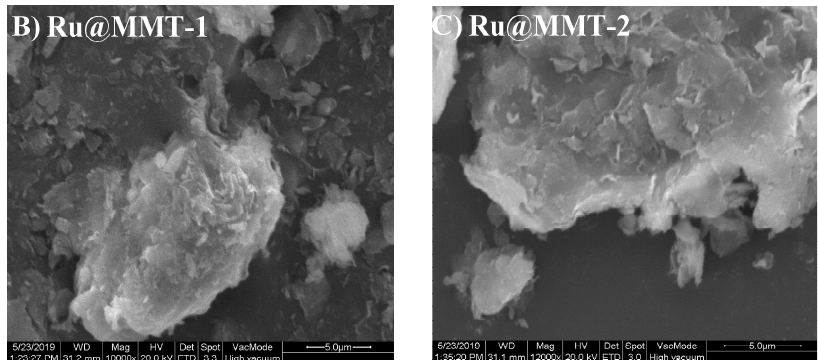
Figure 4. The Scanning electron microscopy (SEM) micrograph of Na-MMT ( A ), Ru@MMT-1 ( B ) and Ru@MMT-2 ( C ) at 5.0 μm provided the information about the layers formation.